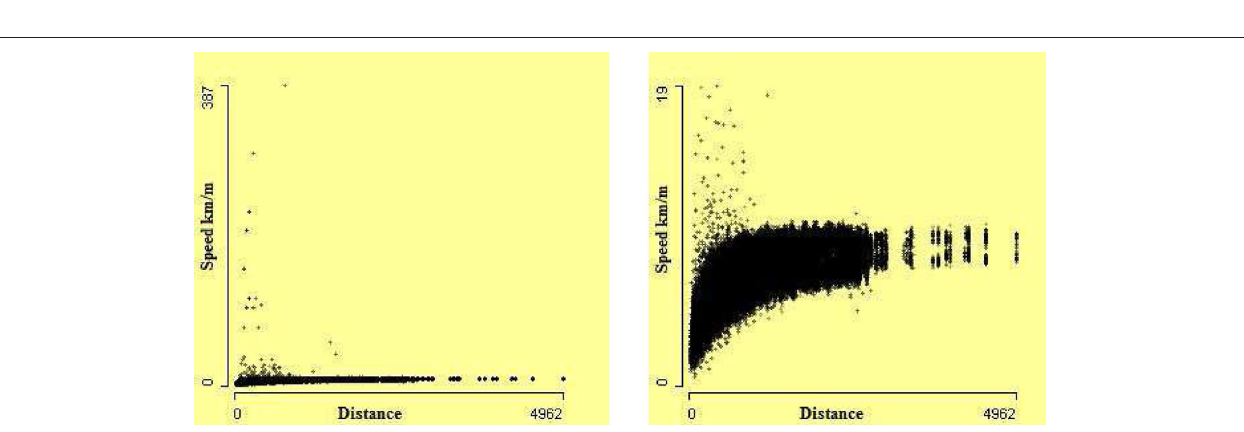
FIgurE 5 | Boxplots of aircraft average speed by engine type on top and after zooming in bottom. The zooming shows aircraft that have very low average speed.